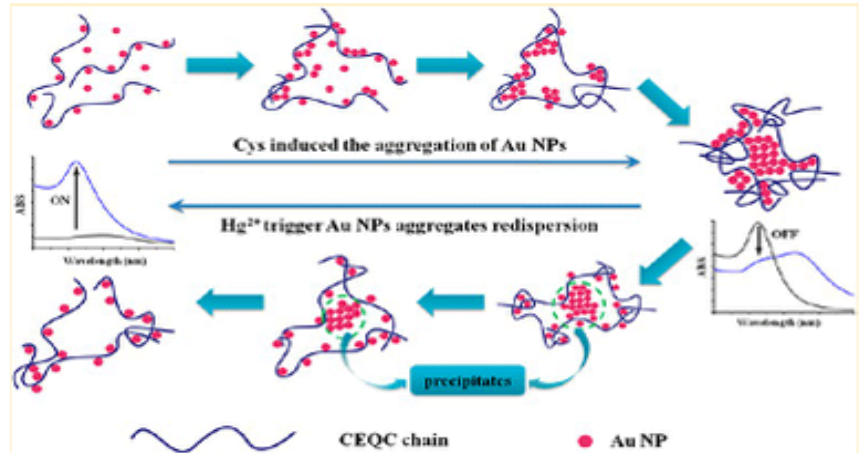
Fig. 9. Carboxylethylquaternizedcellulose stabilized AuNPs for the detection of Hg 2+ . Reprinted with permission from ref.79. Copy right 2013 American Chemical